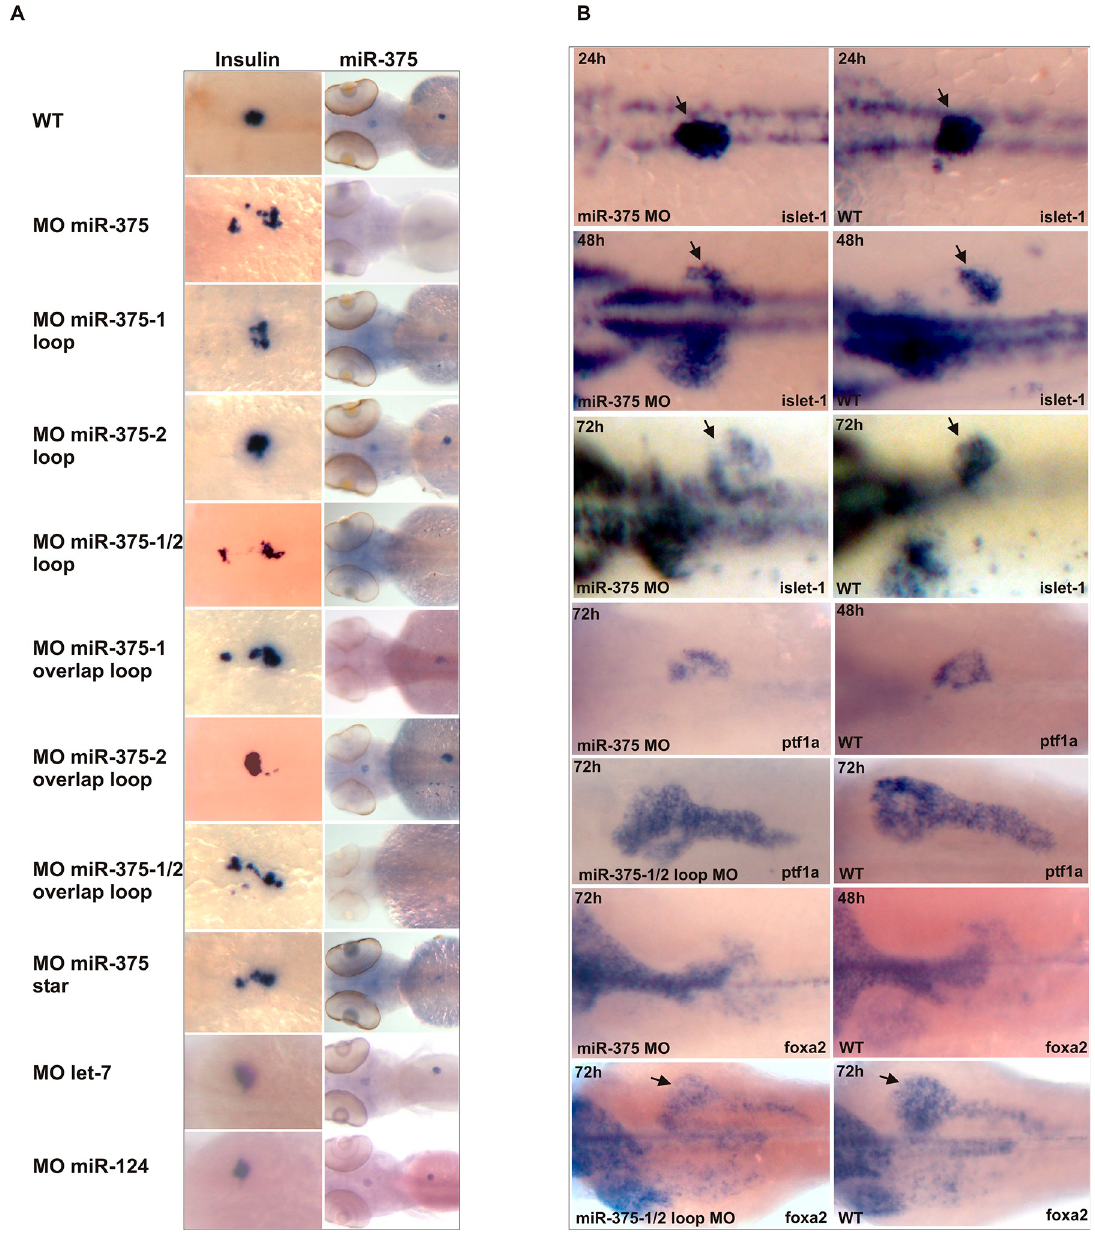
Fig 6. Specific Effects of miR-375 Knockdown on the Development of the Endocrine Pancreas. (A) In situ analysis of miR-375 and insulin expression in 72-hpf embryos injected with morpholinos against the miR-375 precursor and negative control morpholinos for let-7 and miR-124. The WT insulin panel of Fig 6A is identical to the WT 72h panel of Fig 5D, due to these panels representing the same experimental condition. (B) Expression of islet1, foxa2, and ptf1a in wild-type and miR-375 knockdown embryos. Arrows indicate the pancreatic islet. WT, wild